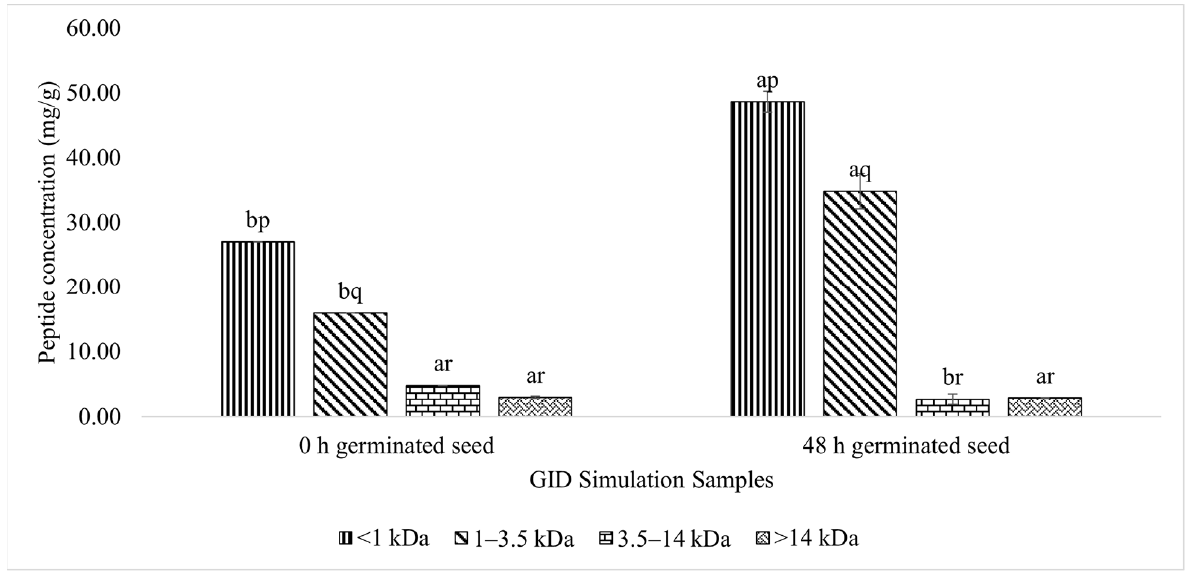
Figure 3. Peptide concentration of the germinated lamtoro gung flour at different fractions after the GID simulation. Values are means with their SDs. a and b indicate significant differences between the same fraction peptide in different samples ( t -test, α = 0.05). p, q, and r indicate significant differences between the different peptide fractions in the same sample (Duncan’s test, α = 0.05).